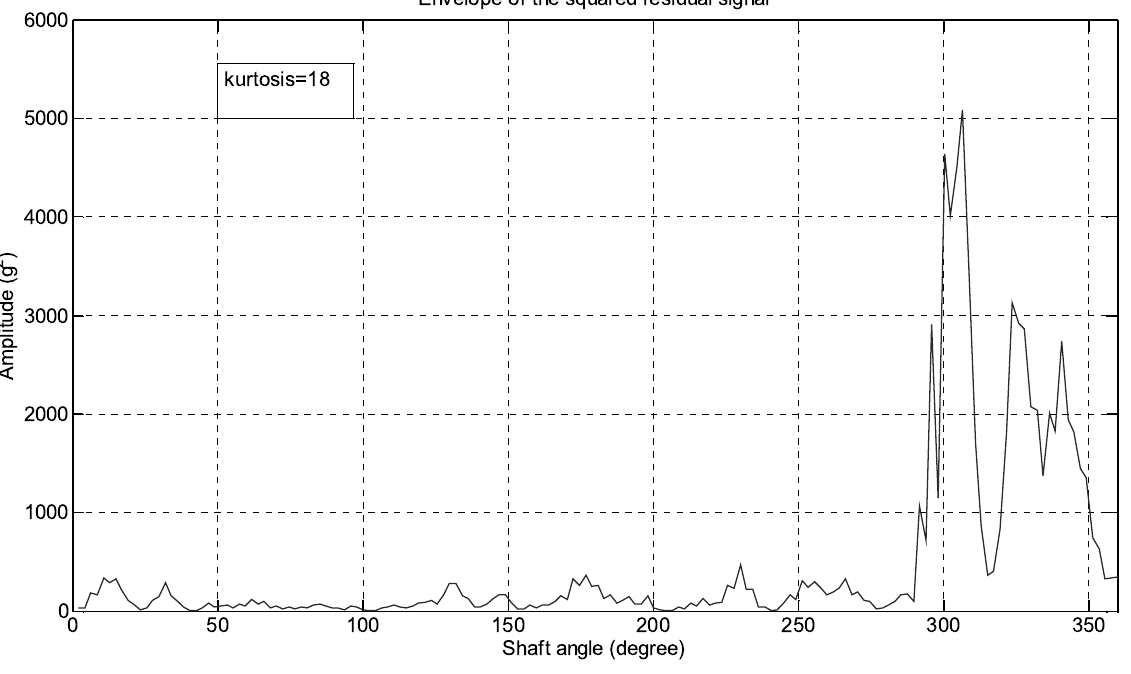
Fig. 25. Envelope of the squared residual signal in the time domain for the fully broken tooth (9th